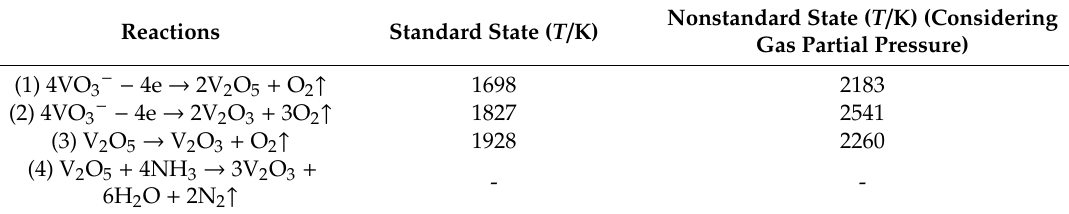
Table 8. The minimum temperature of spontaneous